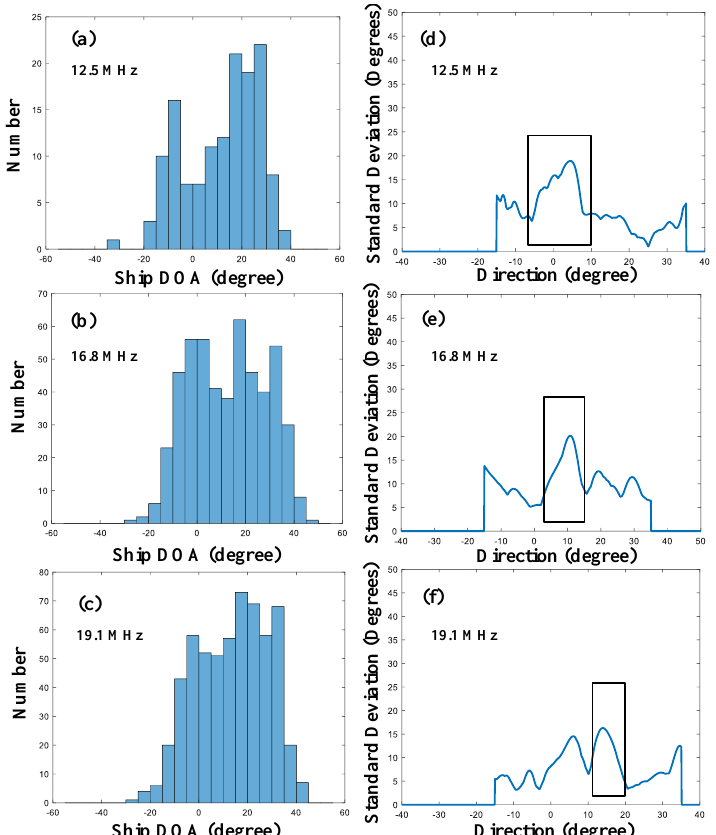
Figure 8. The measure of the number of AIS points with ship DOA: ( a ) 12.5 MHz; ( b ) 16.8 MHz; ( c ) 19.1 MHz. The mean differences between the ideal phase and the fitting phase against direction at: ( d ) 12.5 MHz; ( e ) 16.8 MHz; and, ( f ) 19.1